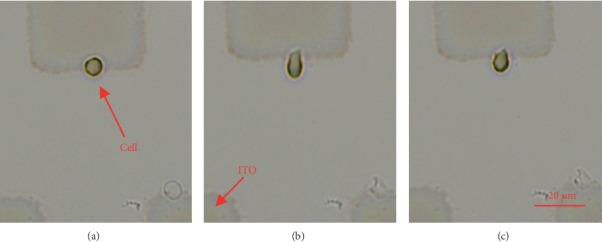
After applying a 10 Vpp sine wave to the ITO electrodes to stretch the cell, the cell did not return to its original shape. The scale bar was 20 μm.